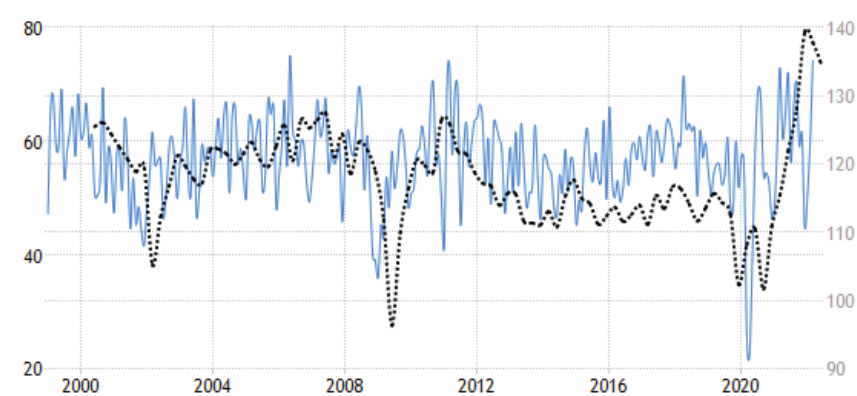
Fig. 4. Business confidence index: India vs Canada. Source: (Trading Economics,